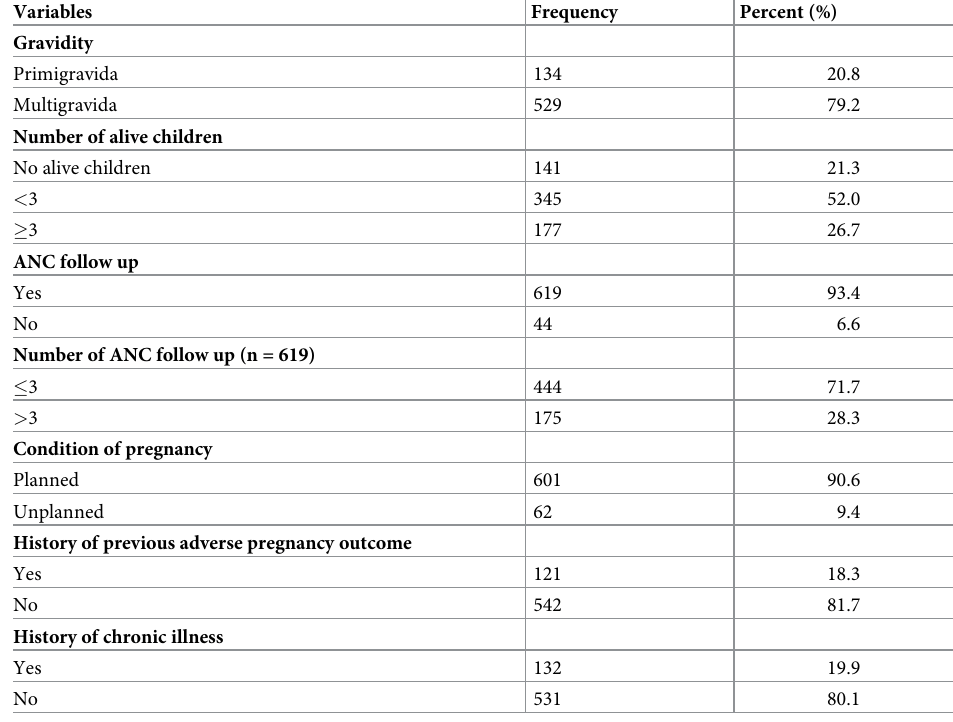
Table 2. Obstetric and reproductive characteristics of pregnant women in Gondar city, northwest Ethiopia, 2021 (n =